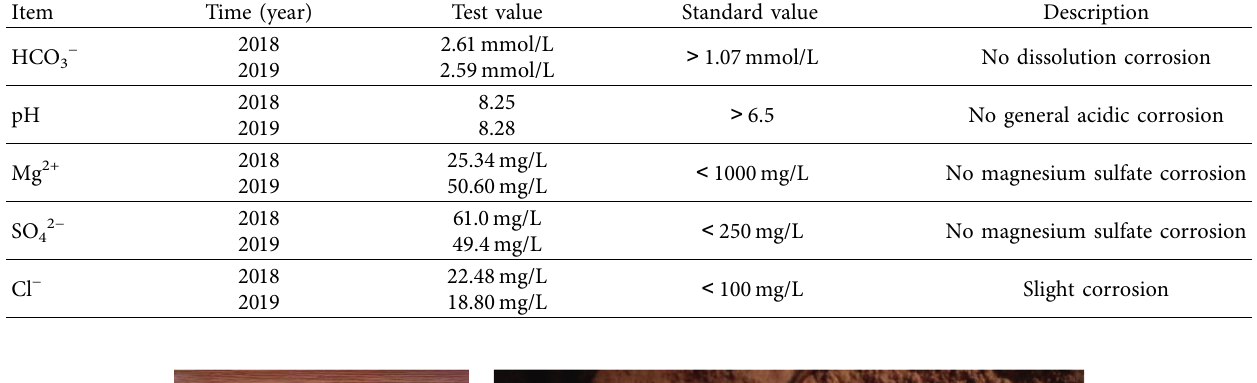
Table 3: Groundwater aggressivity in the underground main powerhouse.